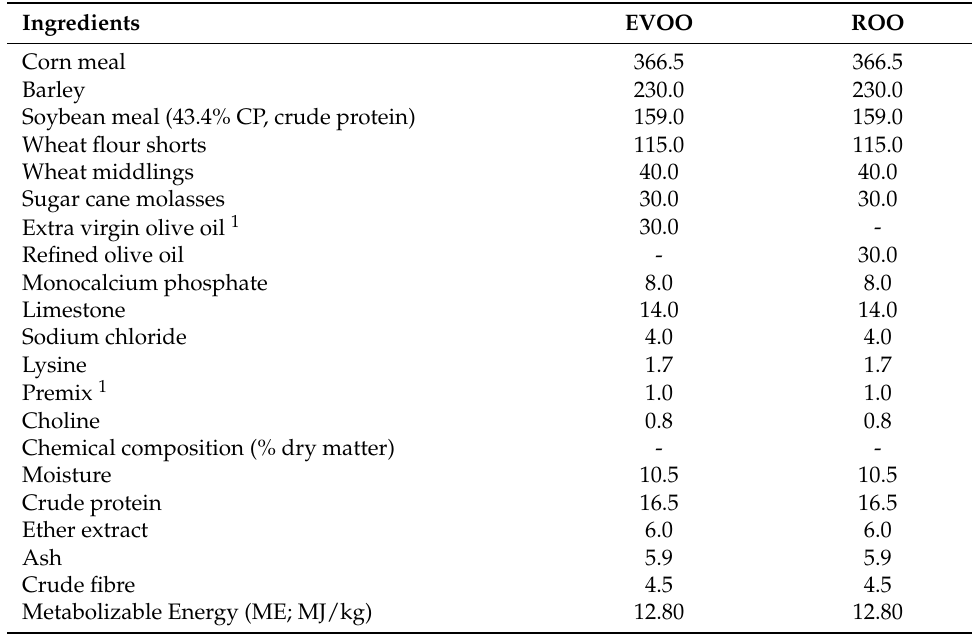
Table 1. Feed ingredients (g/kg, as-fed basis) and chemical composition (% dry matter) of the pelleted